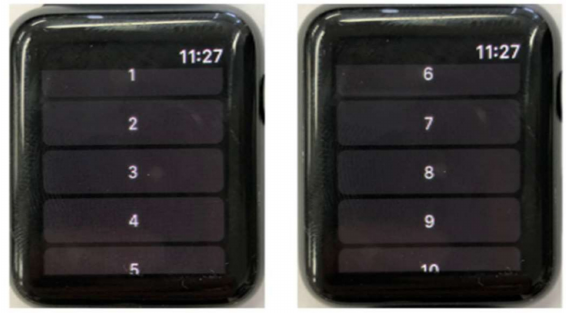
Figure 2. Label selection screen of smartwatch